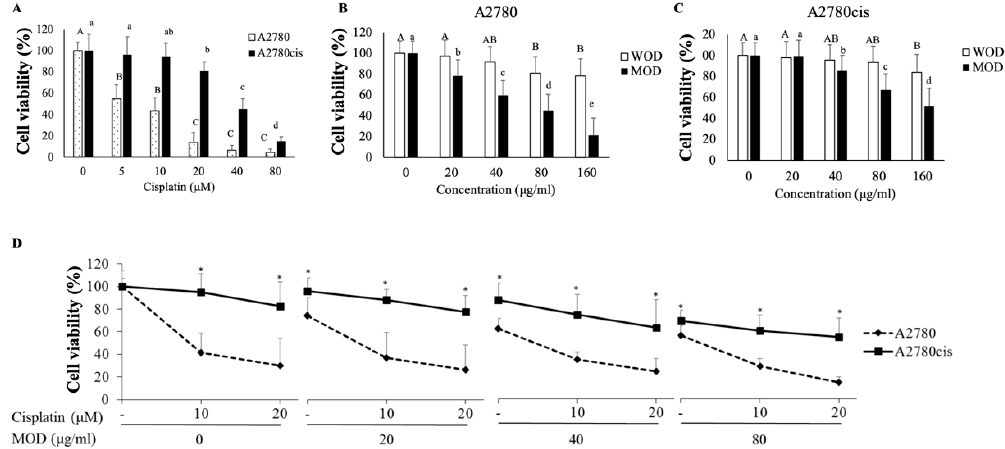
Figure 1. Cisplatin and OD a ff ect cell viability of ovarian cancer cells. Cell viability